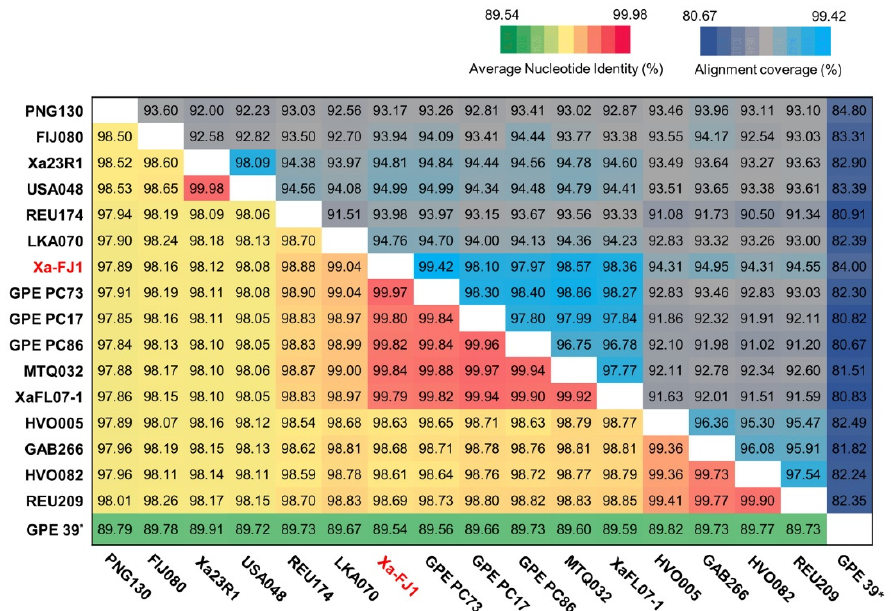
Figure 2. Heat map of average nucleotide identity (ANI) and alignment coverage based on the entire genome sequence of 16 strains of X. albilineans and one strain of X. pseudalbilineans . Strain Xa-FJ1 sequenced in this study is written in red. ANI values (%) and alignment coverage (%) of each two-genome sequence comparison are shown in the lower triangle and in the upper triangle of the matrix, respectively. * The last bacterial strain (GPE 39) does not belong to X. albilineans but to X. pseudalbilineans and was used as an outgroup.